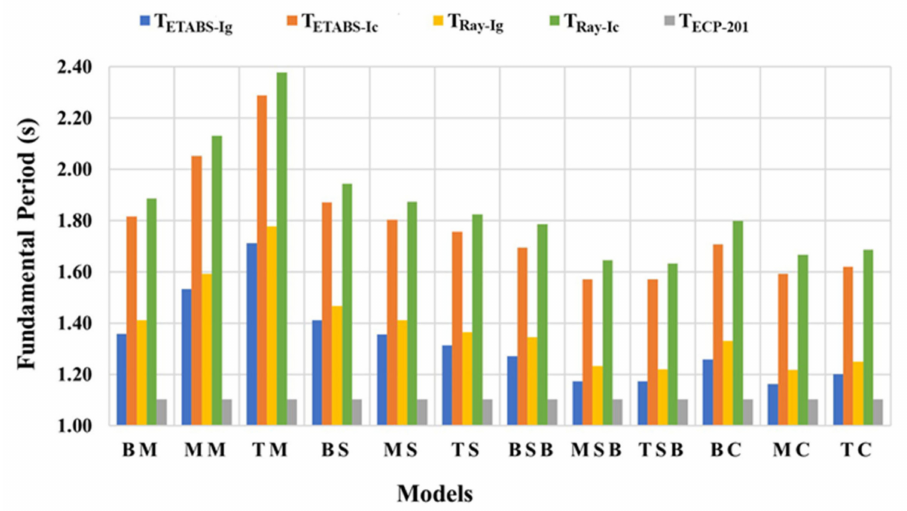
Figure 8. Determination of fundamental time period using three methods adopted in